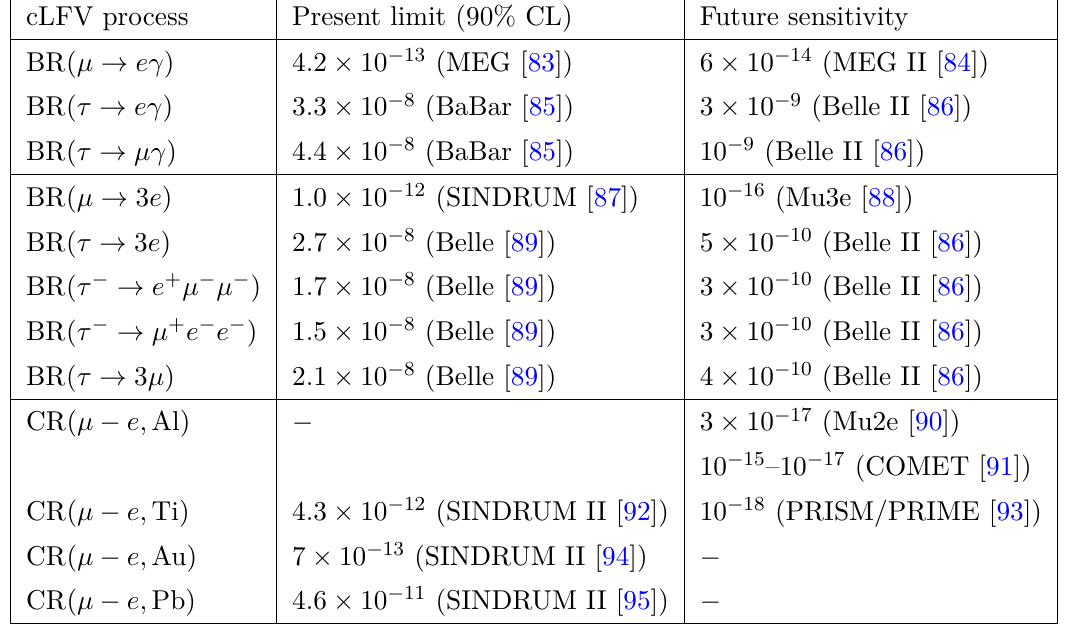
Table 5 . Current experimental bounds and future sensitivities for the branching ratios (BRs) and conversion rates (CRs) of cLFV